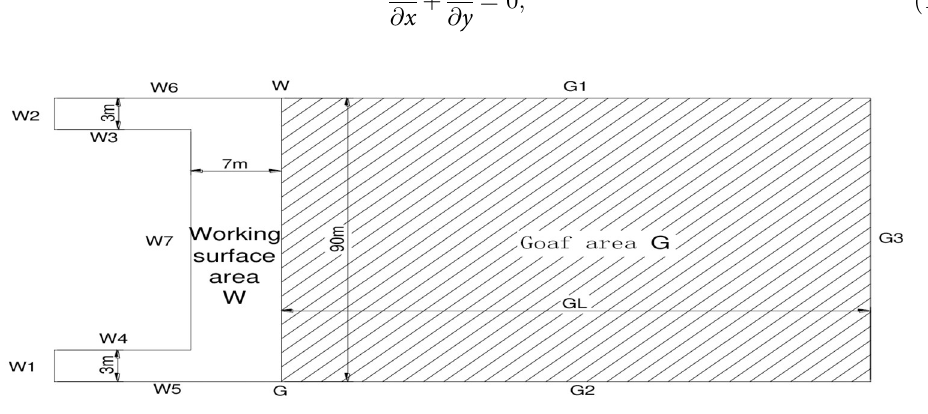
Fig 3. Geometric model of